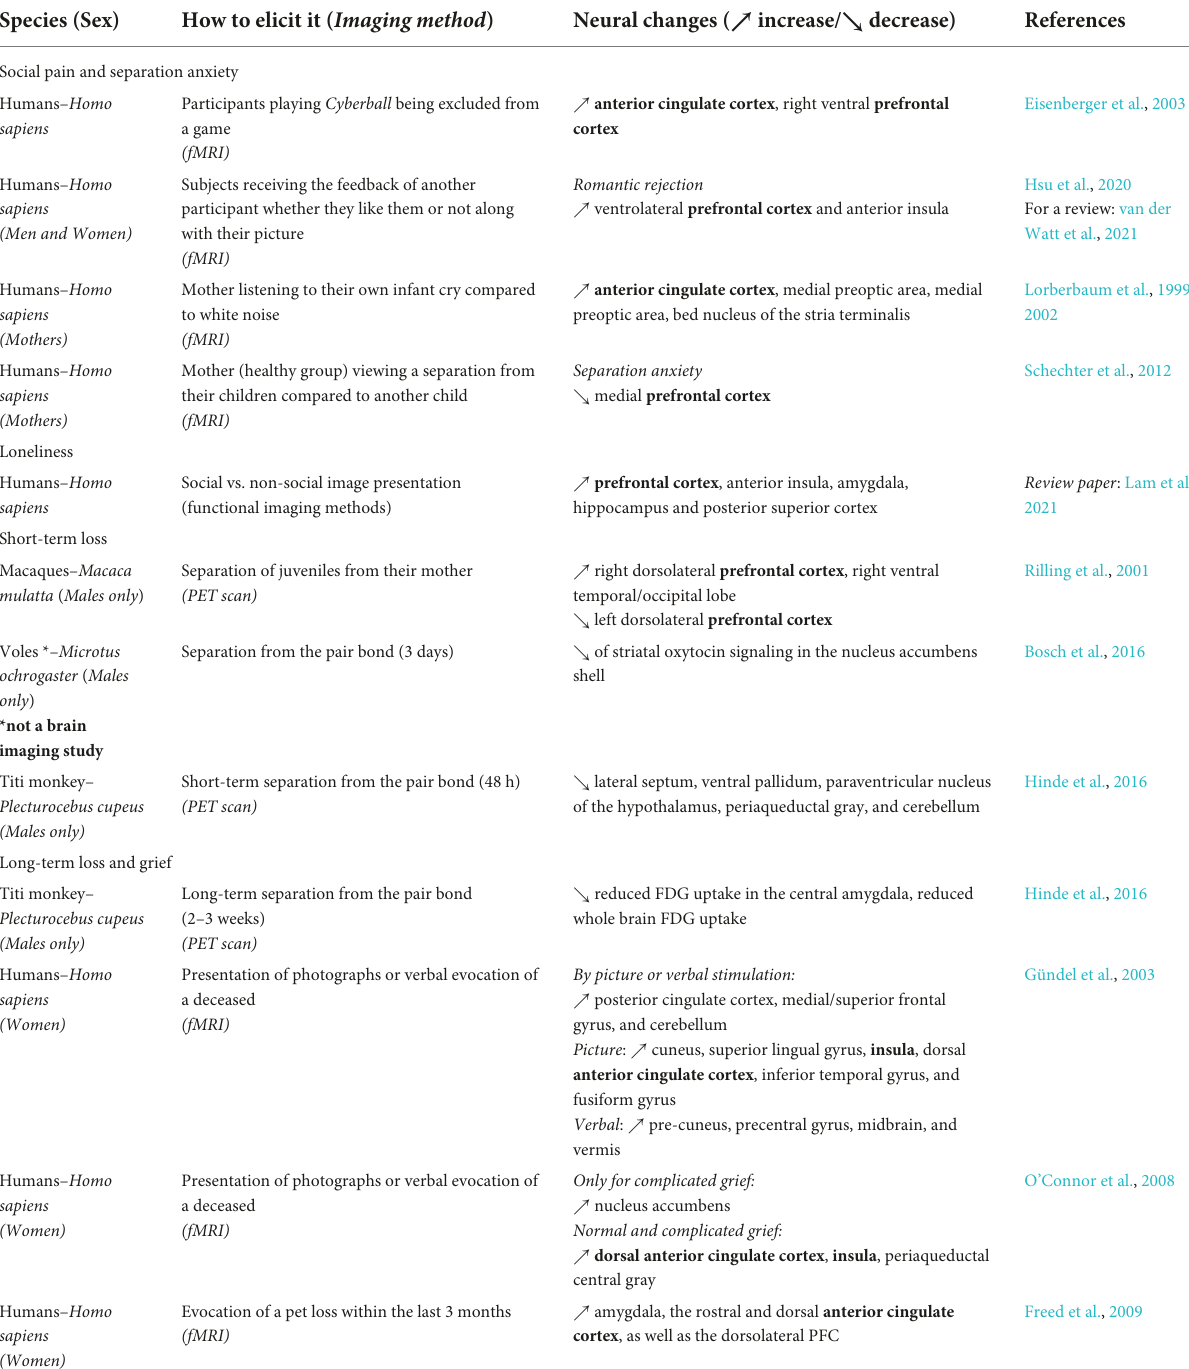
TABLE 5 Summary of the brain areas involved in the expression of separation across